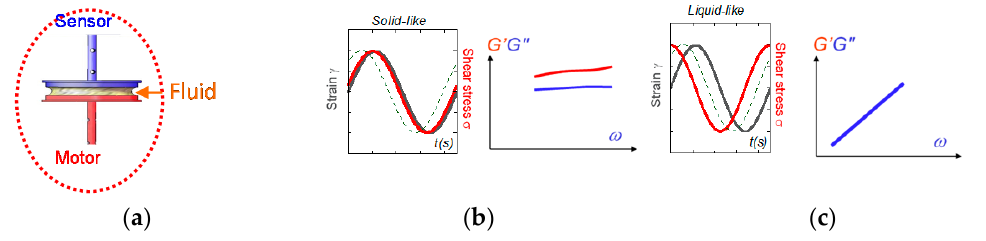
Figure 6. ( a ) The rheology measurement results from a transmission chain of the information: the stress is transmitted via the first surface from the motor (here a sine oscillation) to the sample via molecular contacts, is communicated along the sample thickness, and is transferred via molecular contacts to the second surface coupled to a force (torque) sensor. ( b ) When input and output waves are close in phase, the fluid exhibits a solid-like behavior (G’ > G” and G’ and G” weakly dependent on the frequency). ( c ) When input and output waves are out of phase with a phase shift > π /4 (here π /2), the fluid exhibits a viscous behavior (G’ negligible and G’ and G” vanishing with the frequency). Polymers in diluted, concentrated solutions or in the molten state exhibit versus frequency the typical viscoelastic curve [33]. The low-frequency range characterizes the terminal behavior and is called flow behavior. It is depicted by a ω -scaling decrease of the viscous modulus (G”) and a ω 2 - scaling of the elastic modulus (G’). The flow behavior thus describes the frequency part where the viscous component becomes major. The interception of the two curves defines the terminal time; i.e., the largest time before the material enters in a flow regime. This characteristic time is interpreted as